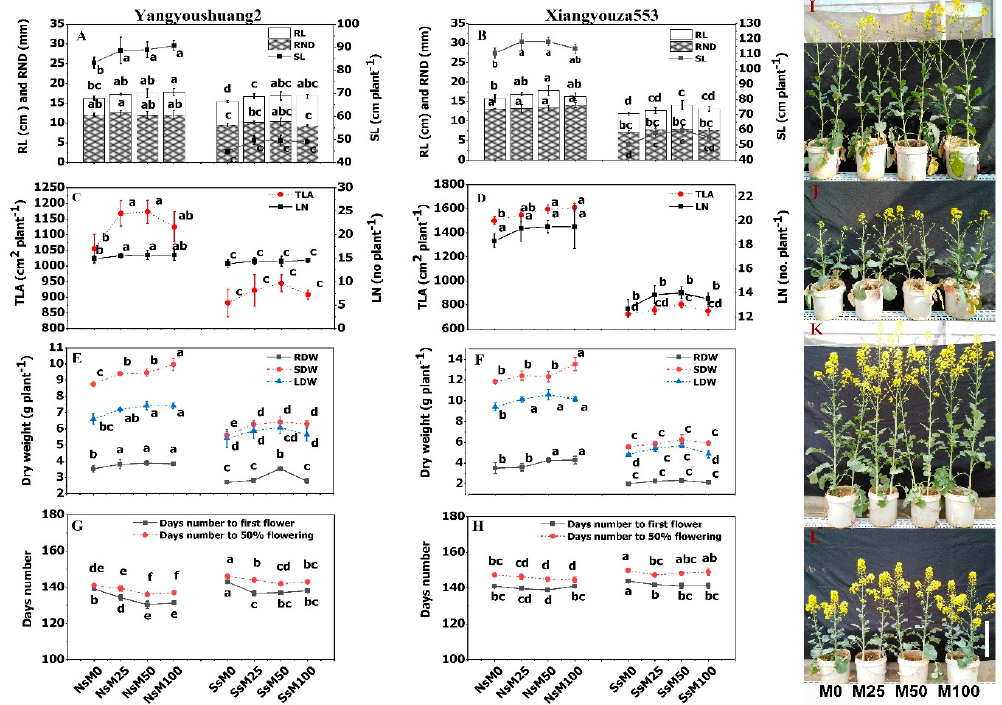
Figure 1. Effect of seed priming using 0 µM (M0), 25 µM (M25), 50 µM (M50) and 100 µM melatonin (M100) on root length (RL), root neck diameter (RND), shoot length (SL), number of leaves (NL), total leaves area (TLA), root dry weight (RDW), stem dry weight (SDW), leaves dry weight (LDW), and days required to first flower ( DNFF ) and 50% flowering (DN50F) of two rapeseed cultivars irrigated with saline water. Ns: no NaCl stress, Ss: salt (NaCl) stress. ( A ) RL, RND and SL of Yangyoushuang2; ( B ) RL, RND and SL of Xiangyouza553; ( C ) TLA and LN of Yangyoushuang2; ( D ) TLA and LN of Xiangyouza553; ( E ) RDW, SDW and LDW of Yangyoushuang2; ( F ) RDW, SDW and LDW of